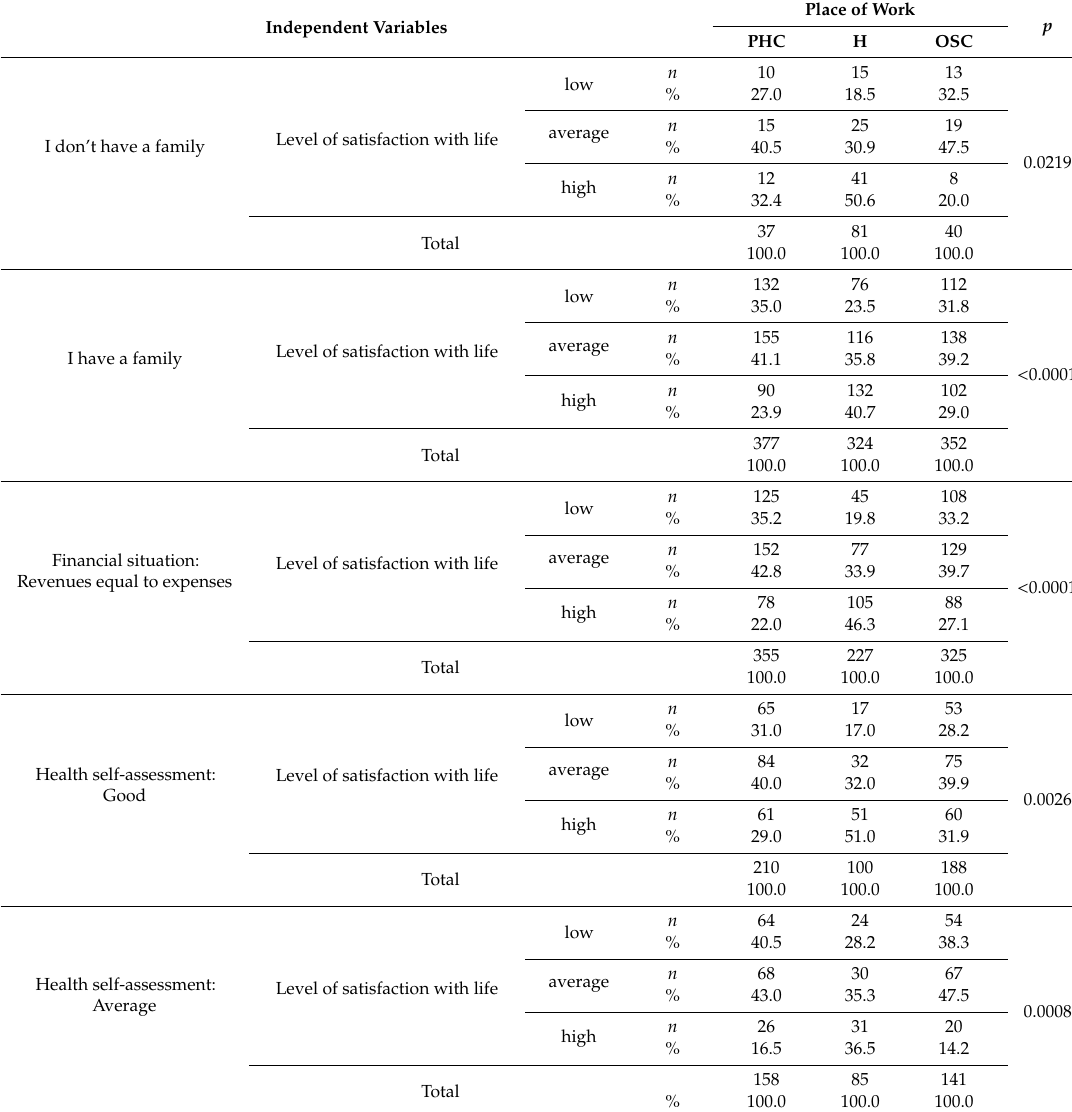
Table 5. Place of work and level of life satisfaction depending on family ownership, financial situation, and self-assessment of